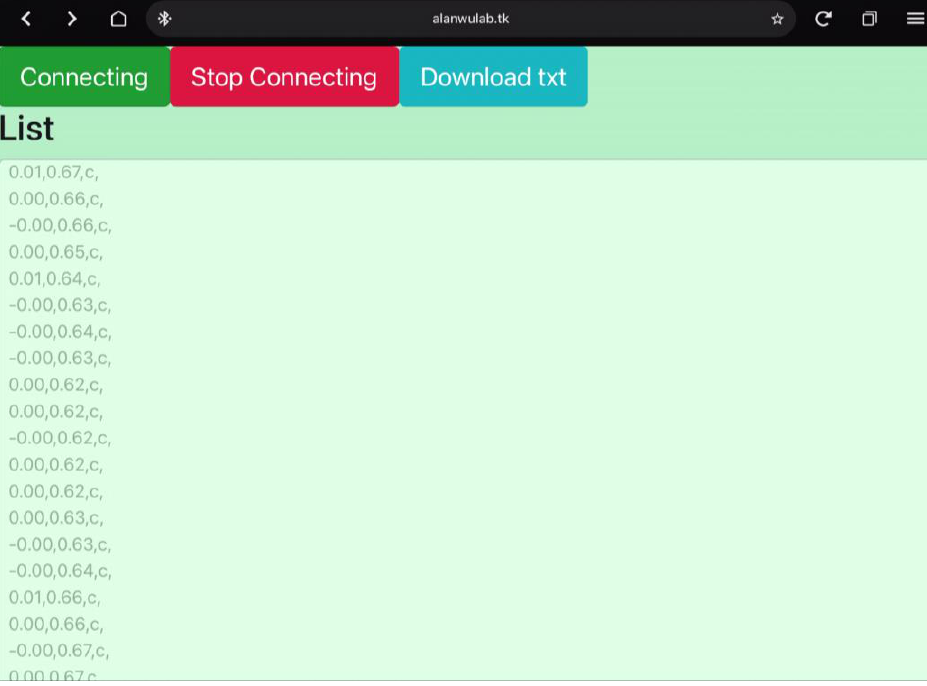
Figure 13. Fall detection of CPGAFDWD in iOS.